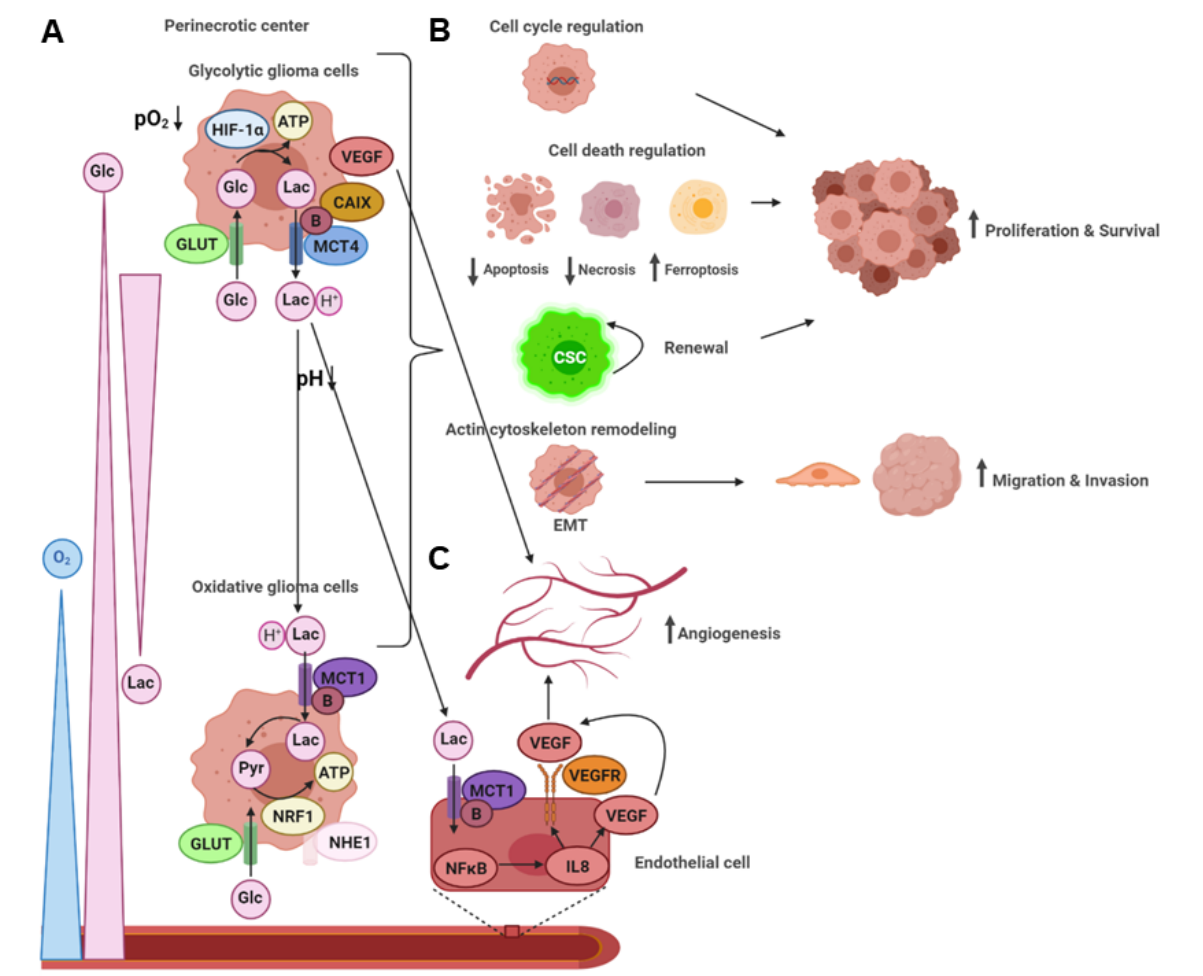
Figure 3. Glycolytic and angiogenic switch in the tumor microenvironment. ( A ) The metabolic symbiosis model between oxidative and glycolytic glioma cells. Under hypoxia, glioma cells in the perinecrotic center upregulate different genes regulated by HIF-1α. Oxidative glioma cells at the leading edge show a different gene expression profile. Glycolytic glioma cells release lactic acid into the tumor microenvironment, leading to acidity. Lactic acid is taken up by oxidative glioma cells, preferably to glucose, thereby enhancing the glucose gradient from blood vessels to glycolytic glioma cells in the tumor center. ( B ) Functional consequences on glioma malignancy. The glycolytic switch leads to increased proliferation and survival by cell cycle and cell death regulation, a CSC phenotype, and enhanced migration and invasion by EMT and actin cytoskeleton remodeling. ( C ) Glycolytic and angiogenic switch. The glycolytic switch induces angiogenesis by VEGF upregulation in glycolytic glioma cells and stimulation of autocrine VEGF signaling in endothelial cells by lactate. B: basigin .